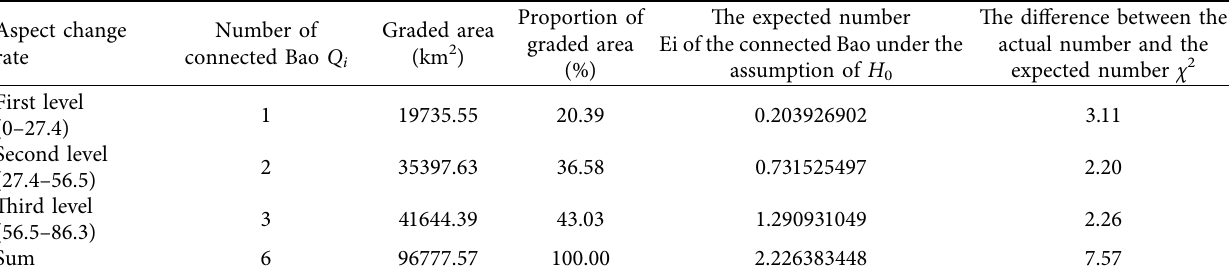
Table 6: Univariate chi-square test for the aspect change